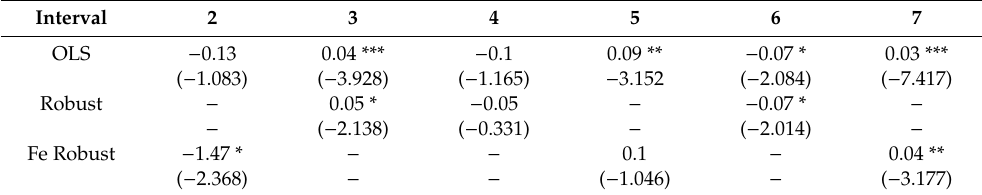
Table 7. Relative Spread’s Coe ffi cient after Robust used to Rectify the problem in